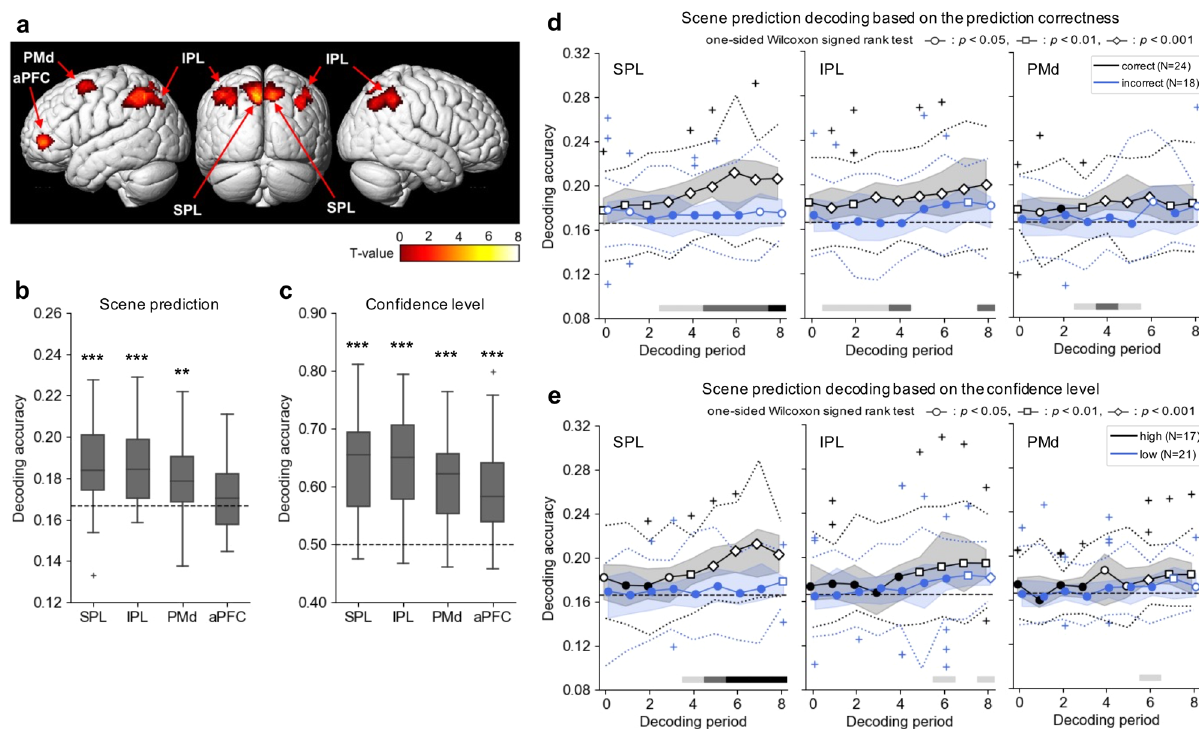
Fig. 3 Imaging analysis results and decoding accuracies. a Brain areas that were signi fi cantly activated when subjects were predicting an upcoming scene: bilateral superior parietal lobule (SPL), bilateral inferior parietal lobule (IPL), left dorsal premotor cortex (PMd), and left anterior prefrontal cortex (aPFC). The voxel activity patterns in these four areas were used to construct decoders for each region of interest (ROI) for scene prediction and con fi dence level. Visualization was performed using xjView toolbox (https://www.alivelearn.net/xjview). b , c Decoding accuracies for scene prediction ( b , six types of scenes) and its con fi dence level ( c , high or low) within each ROI evaluated using leave-one-session-out (LOSO) cross-validation (CV). Each box extends from the lower to upper quartiles, with a horizontal line at the median. The whiskers represent 1.5 × IQR, and cross markers indicate the outliers. Signi fi cance was tested using a one-sided Wilcoxon signed-rank test compared to chance (dashed line) (**: p < 0.01, ***: p < 0.001). These fi gures represent the results of the scene prediction and con fi dence decoders using the 6th decoding period as representative data because of its increasing decodability in our time-series analysis; the overall results of the time-series decoding analysis are shown in Supplementary Fig. 4b – e. d , e Time-series scene prediction decoding results within each ROI when the data were categorized binarily according to the prediction correctness ( d , correct vs. incorrect trials) and the con fi dence level ( e , high-con fi dence vs. low-con fi dence trials) of the prediction trial. For example, ‘ correct ’ indicates the accuracy of the scene prediction decoder trained and tested with only the trials in which subjects ’ upcoming scene selections were correct (correct-only decoder). The decoding accuracies were evaluated using the leave-one-game-out (LOGO) CV. The solid lines re fl ect the median, the shaded areas indicate the range between the upper and lower quartiles, and the dotted lines indicate the range of 1.5×IQR. The cross-markers indicate outliers. Signi fi cance was tested using a one-sided Wilcoxon signed-rank test (un fi lled circle: p < 0.05, un fi lled square: p < 0.01, un fi lled diamond: p < 0.001) compared to the chance level (dashed line). The color of the horizontal line below the plots re fl ects a signi fi cant difference between the two categories of trials in each decoding period (one-sided Wilcoxon rank-sum test, light gray: p < 0.05, dim gray: p < 0.01, black: p <